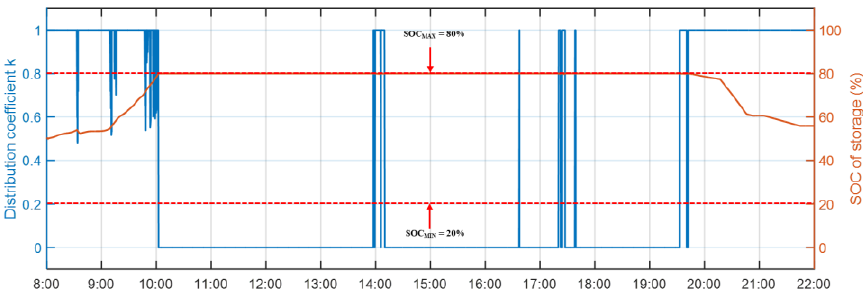
Figure 22. Storage soc and distribution coe ffi cient k under Figure 22. Storage 𝑠𝑜𝑐 and distribution coefficient 𝑘 under SPVA. Figure 22. Storage 𝑠𝑜𝑐 and distribution coefficient 𝑘 under SPVA.